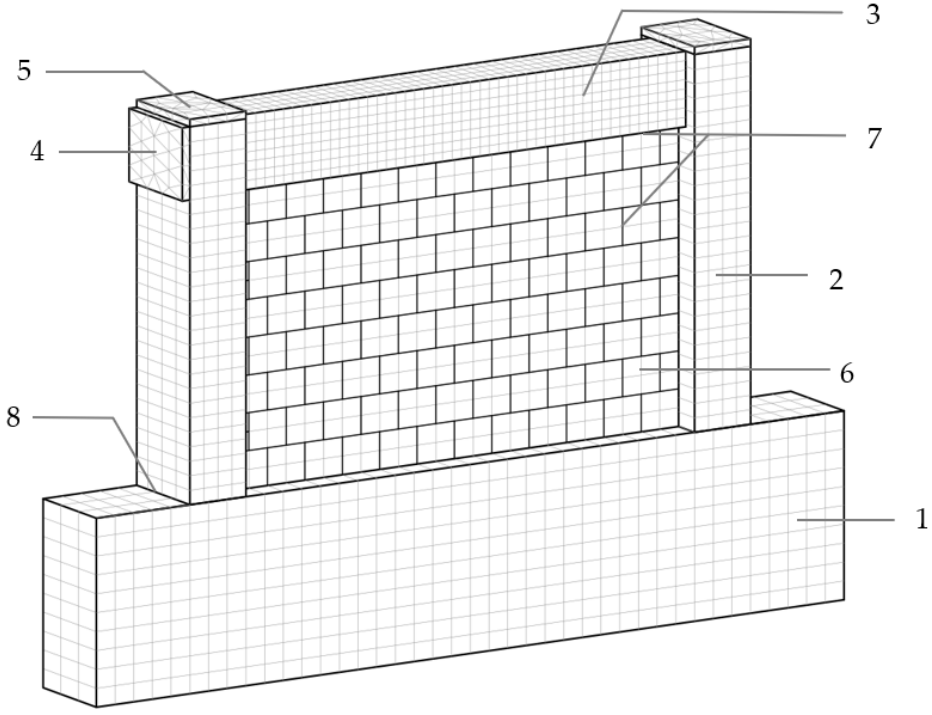
Figure 3. Macro elements, interfaces and meshing method of the meso model. Table 2. General definition of macro element—the interface of meso modeling.